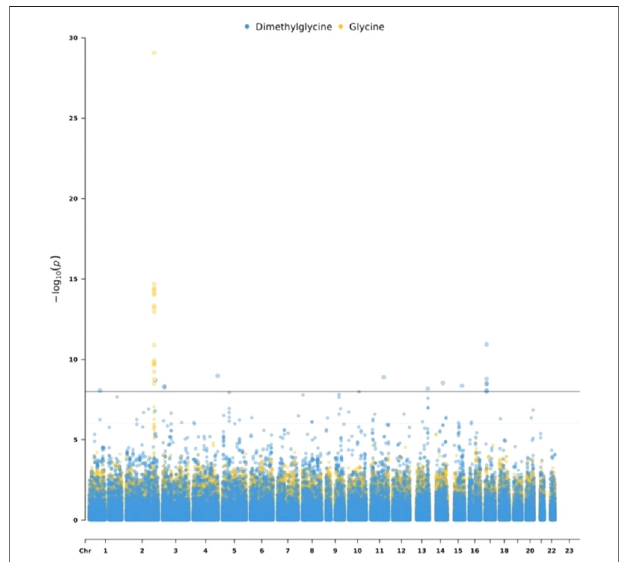
FIGURE 2 | Manhattan plot for Dimethylglycine and Glycine